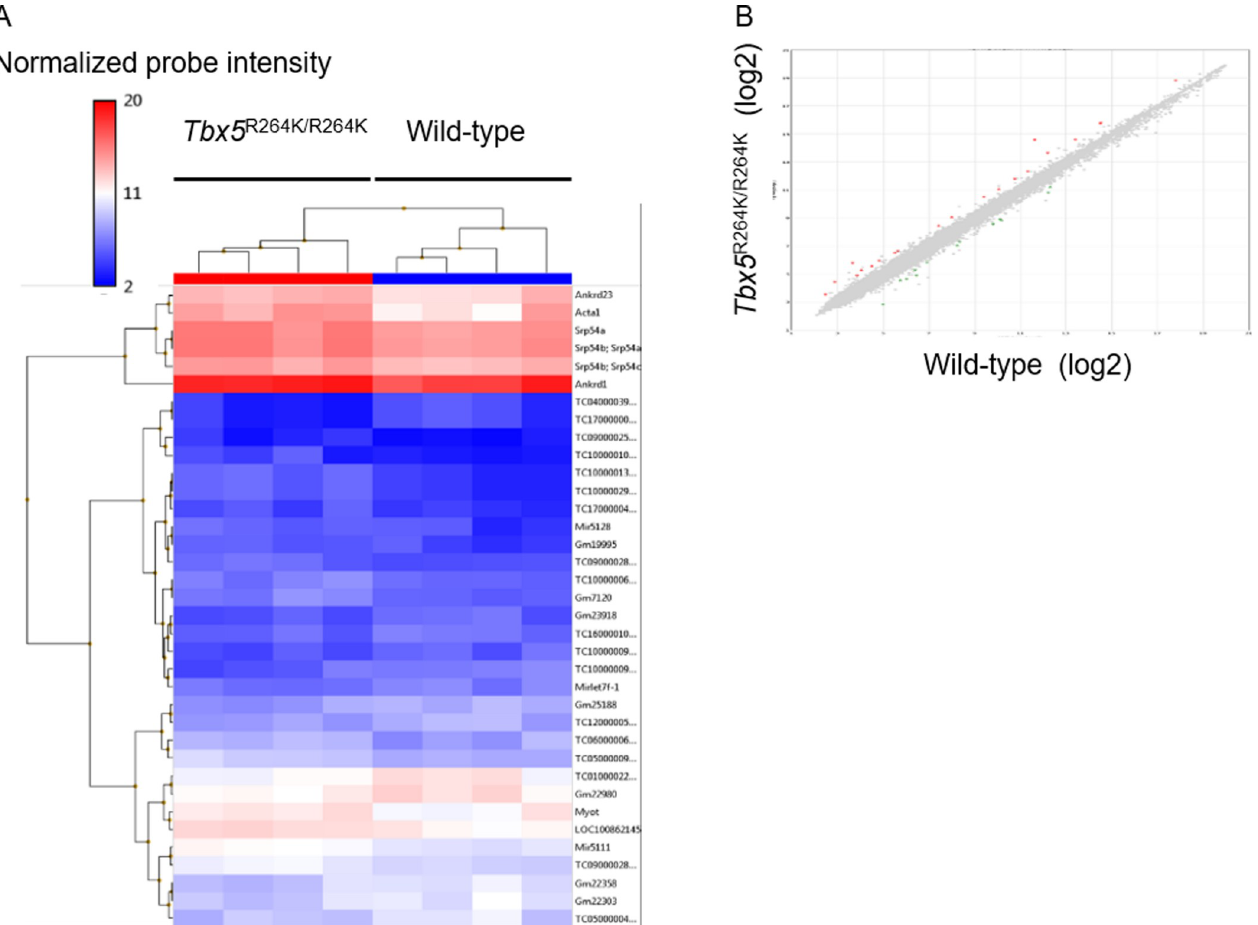
Fig 2. Microarray analysis of RNAs isolated from the left ventricle myocardium of young adult Tbx5 R264K/R264K mice compared with wild-type. A Clustering map shows 36 RNAs were significantly ( P value < 0.05) changed with greater than 2.0 or less than -2.0 fold expression changes. B Scatter plot shows those 36 RNAs indicated as red (increased) and blue (decreased) points.